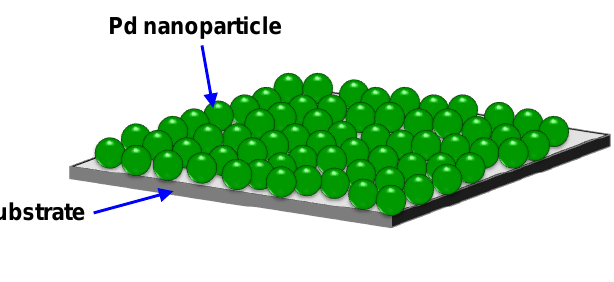
Figure 13. Schematic representation of a continuous film of Pd nanoparticles. Pd